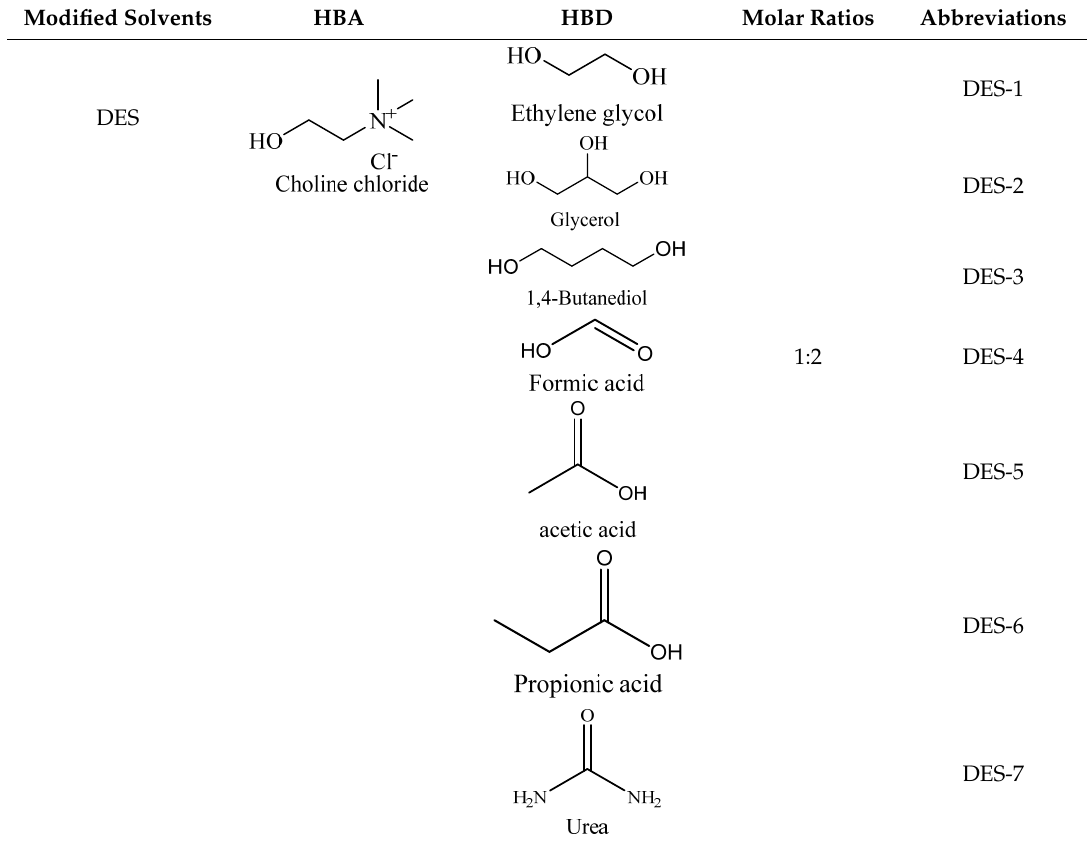
Table 3. Abbreviations of DES as modified solvents.